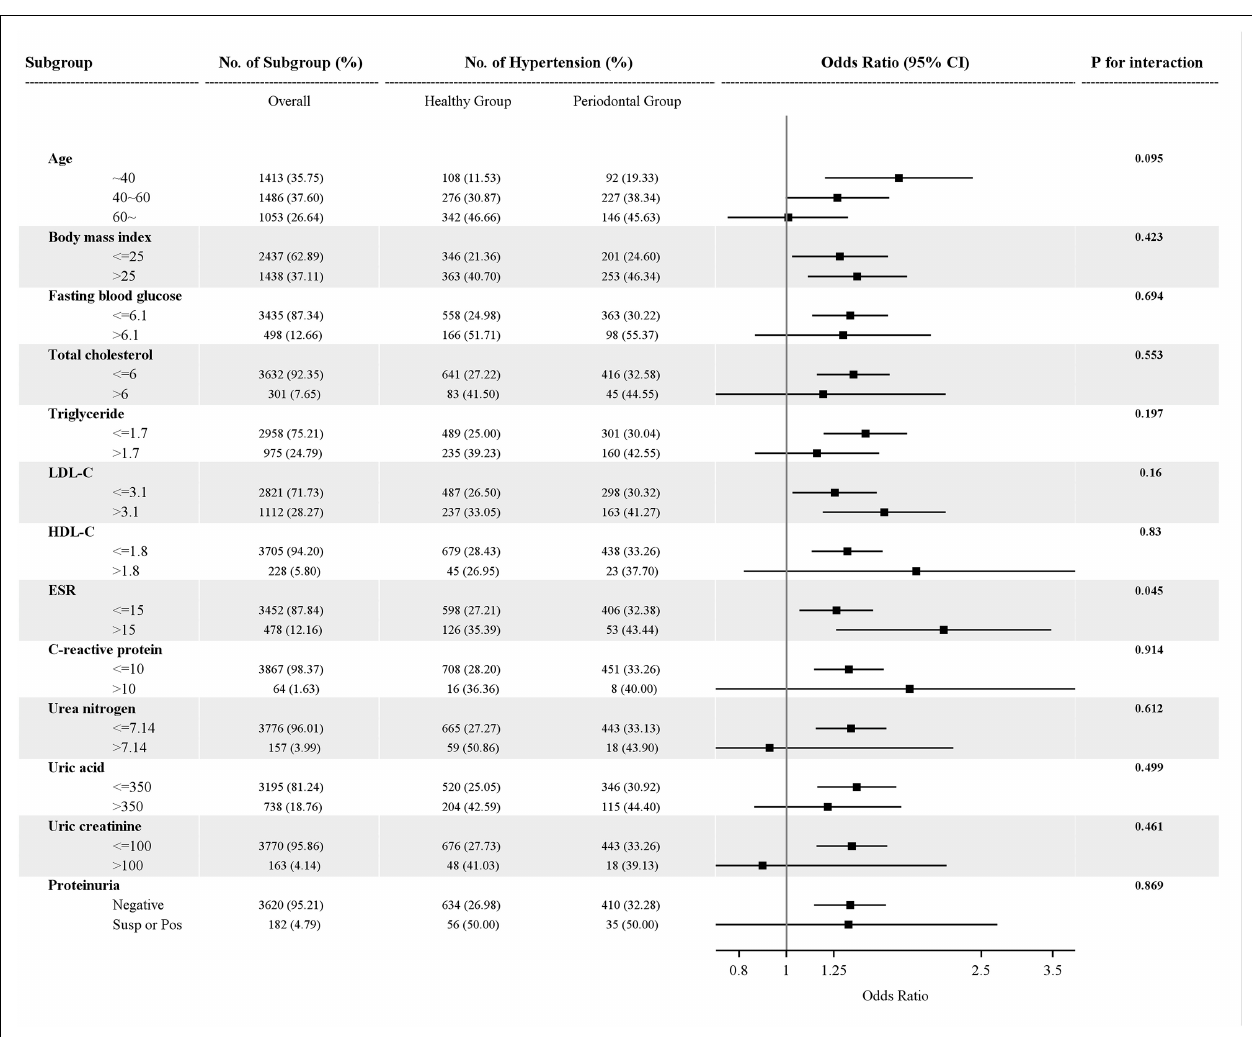
FIGURE 1 | Results of interaction and subgroup analyses of relationship between periodontal disease and hypertension. LDL-C, low-density lipoprotein cholesterol; HDL-C, high-density lipoprotein cholesterol; ESR, erythrocyte sedimentation rate; CI, confidence interval; Susp or pos, suspicious or positive. p for interaction was test by likelihood ratio